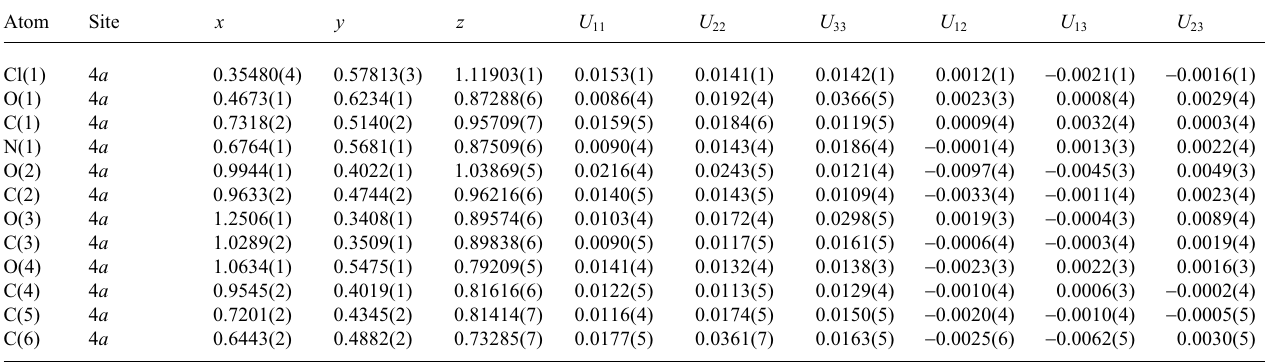
Table 3. Atomic coordinates and displacement parameters (in Å 2 )